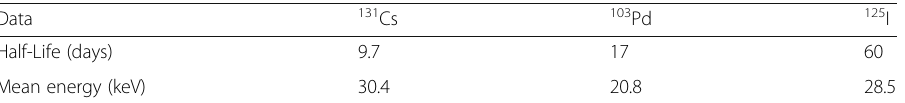
Table 1. The data corresponding to the 125 I, 103 Pd, and 131 Cs radioactive sources as commonly used seeds for eye plaque brachytherapy